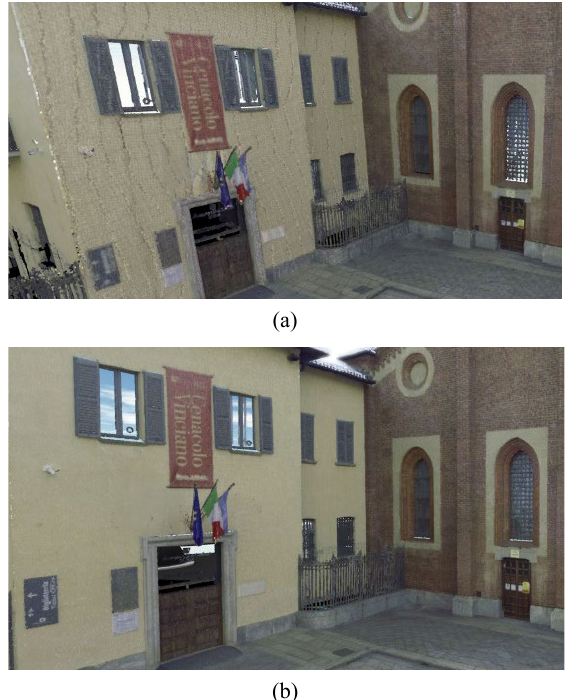
Figure 10 . The Ghesc village top view DEM